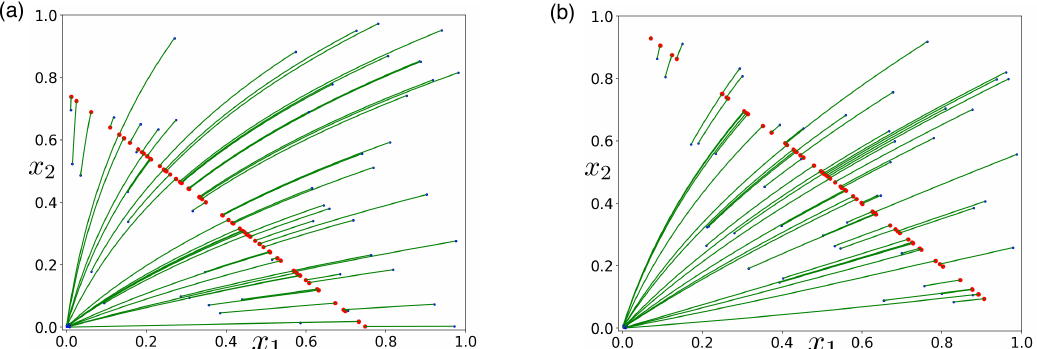
# . Initial Figure 13. Phase portrait showing a continuum of equilibrium points following x 1 + x 2 = 1. Initial ε (line of quasi-neutral  − limit with a red dot. Specific parameters used: conditions are represented with a blue dot and their w limit with a red dot. Specific parameters used:   limit with a red dot. Specific parameters used are: # = 0, # 12 = 0, h k = 0.8, and b = 0.5. − 318